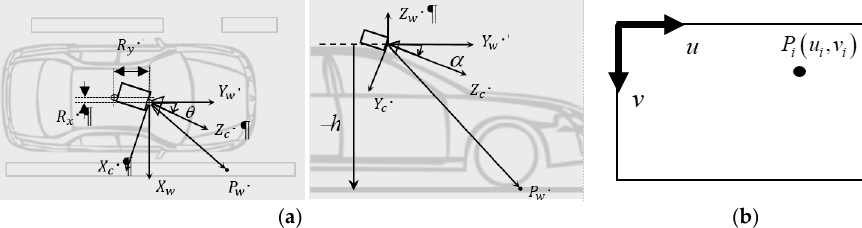
Figure 1a. The transformation from an arbitrary point 𝑃 (cid:3050) (𝑥 (cid:3050) ,𝑦 (cid:3050) ,−ℎ) in the world frame to the corresponding point 𝑃 (cid:3036) (𝑢 (cid:3036) ,𝑣 (cid:3036) ) in the image plane as shown in Figure 1b can be determined by coordinate transformation: